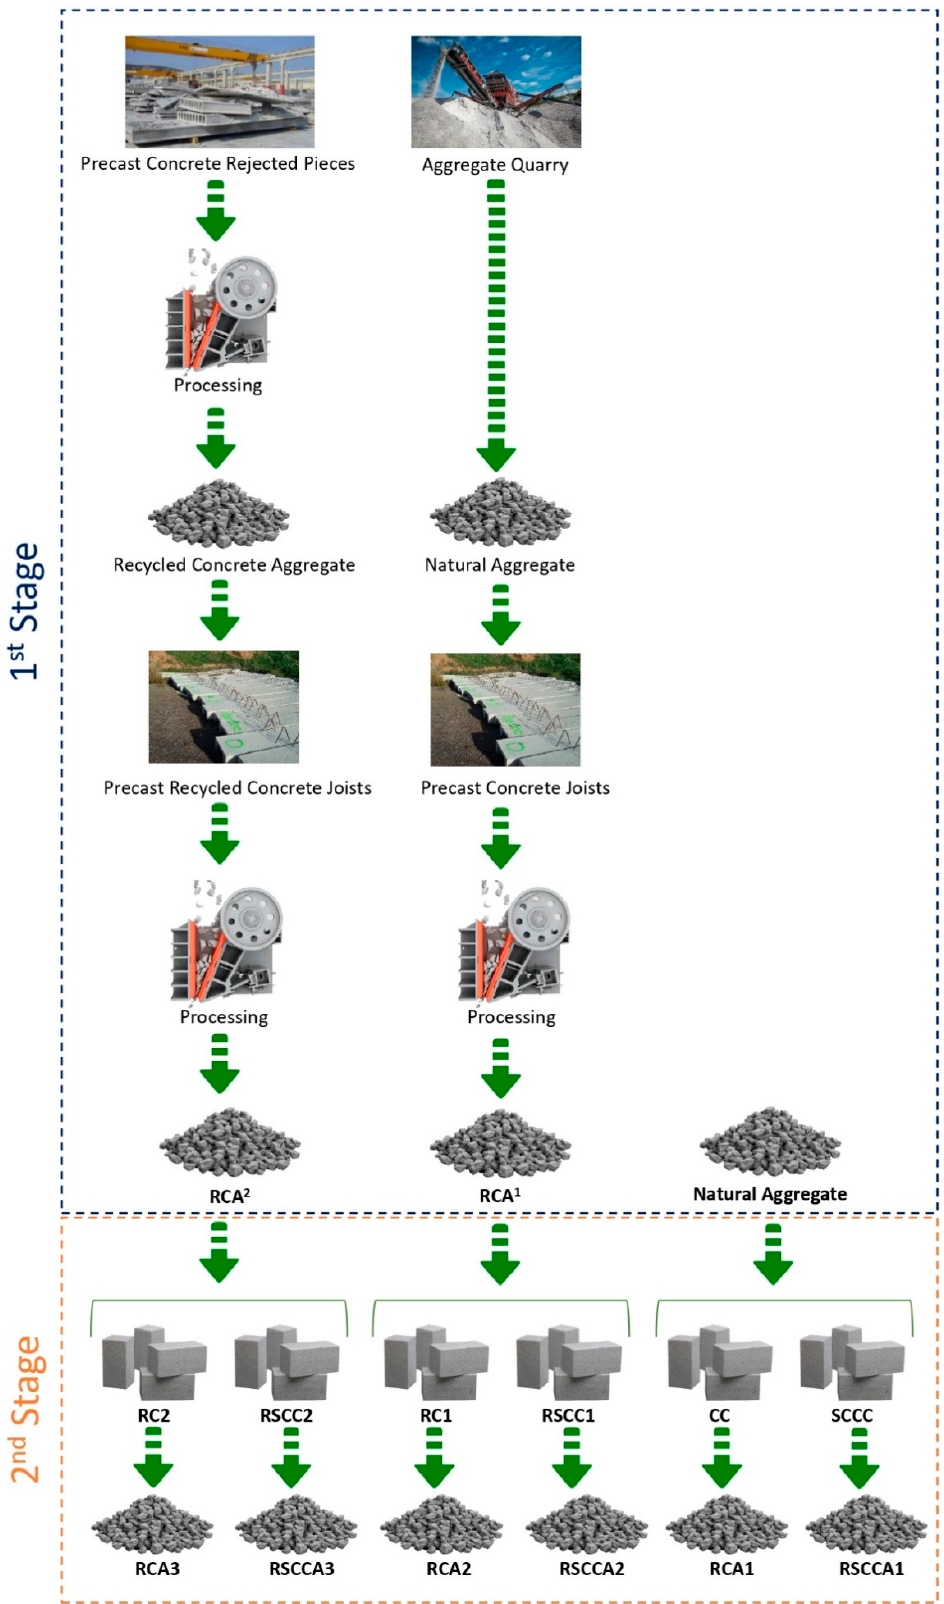
Figure 2. First- and second-stage recycled concretes and aggregates.